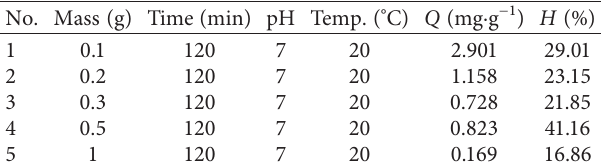
Table 5: Effect of adsorbent weight on Cr (VI) ion adsorption process.